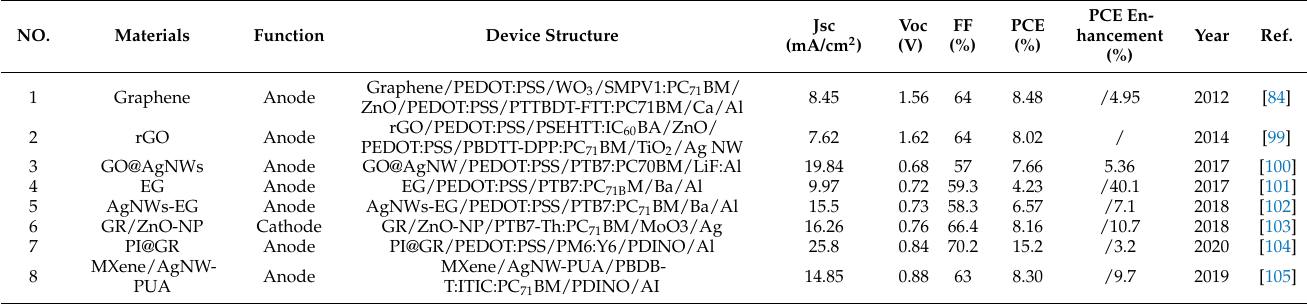
Table 5. 2D layer materials applied as the electrode in